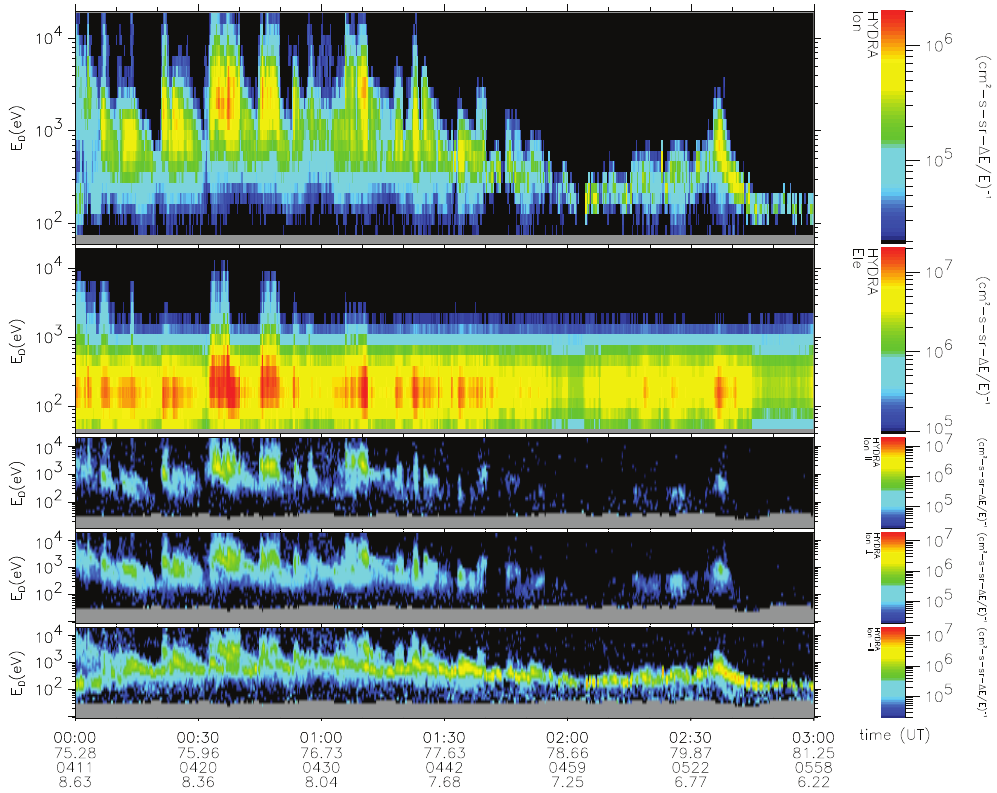
Fig. 6. Polar observations of ion and electron data for the interval 00:00–03:00UT. Panels show: ion and electron differential energy fluxes (DEFs) as well as pitch angle (PA) restricted DEFs for the ions: parallell, perpendicular, and antiparallel to the magnetic field).